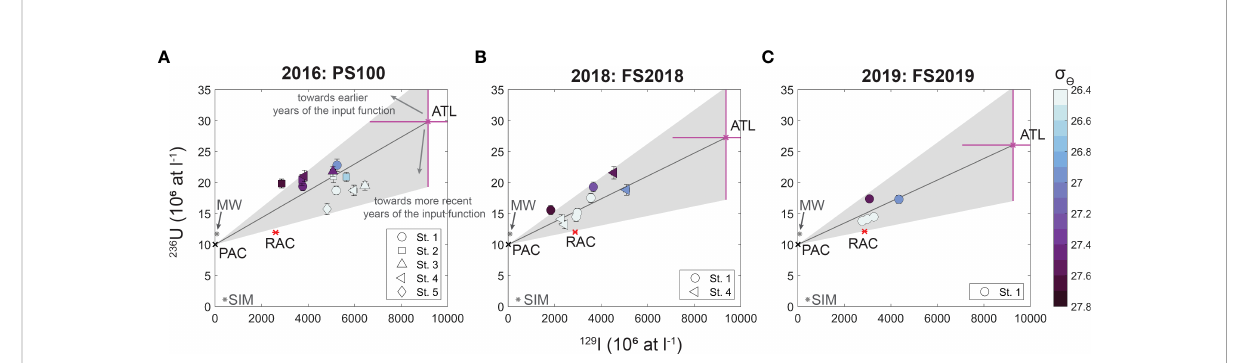
FIGURE 6 236 U- 129 I steady state mixing models for 2016 (A) , 2018 (B) , 2019 (C) . For the ATL endmember, the magenta symbol shows the mean, error bars correspond to a minimum and maximum estimate to account for the transient nature of the ATL input function (see Table 1 and Supplement S4). The gray area illustrates the range of PAC-ATL mixing lines including this uncertainty. PSW samples from matching stations between the three sampling years (Figure 4A) are plotted on top, color coded by potential density ( s Q ). Different symbols refer to different stations. Acronyms are explained in Table 1.